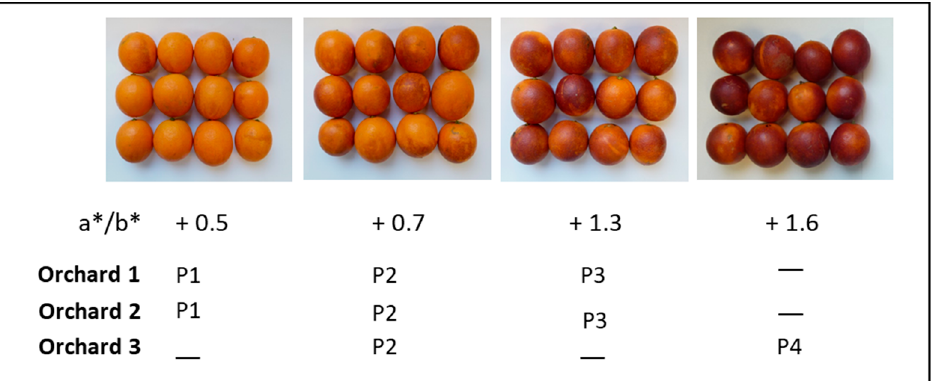
Figure 1. ‘Sanguinelli’ blood oranges grouped according to increased rind pigmentation intensity (P1—slight, P2—medium, P3—intense, P4—very